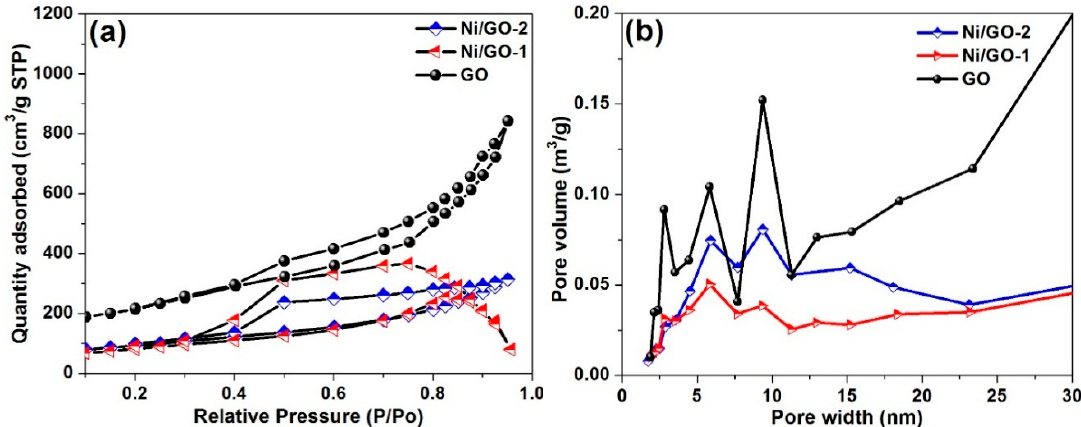
Figure 8. ( a ) Typical N 2 adsorption/desorption isotherm curves of BET isotherm and ( b ) pore volume of GO, Ni/GO-1 and Ni/GO-2.